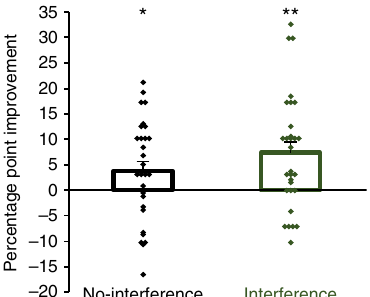
Fig. 9 Auditory classi fi cation performance improvement in experiment-4. The mean percentage-point improvement from day-1 to day-5 is shown for both conditions. The same 30 starlings completed each condition. Asterisks indicate signi fi cant performance changes across the 5-day retention interval within a condition (* P < 0.05; ** P < 0.01 after Holm – Bonferroni corrections). Error bars show standard error of the mean. Dot plots show individual percentage point improvement scores from day-1 to